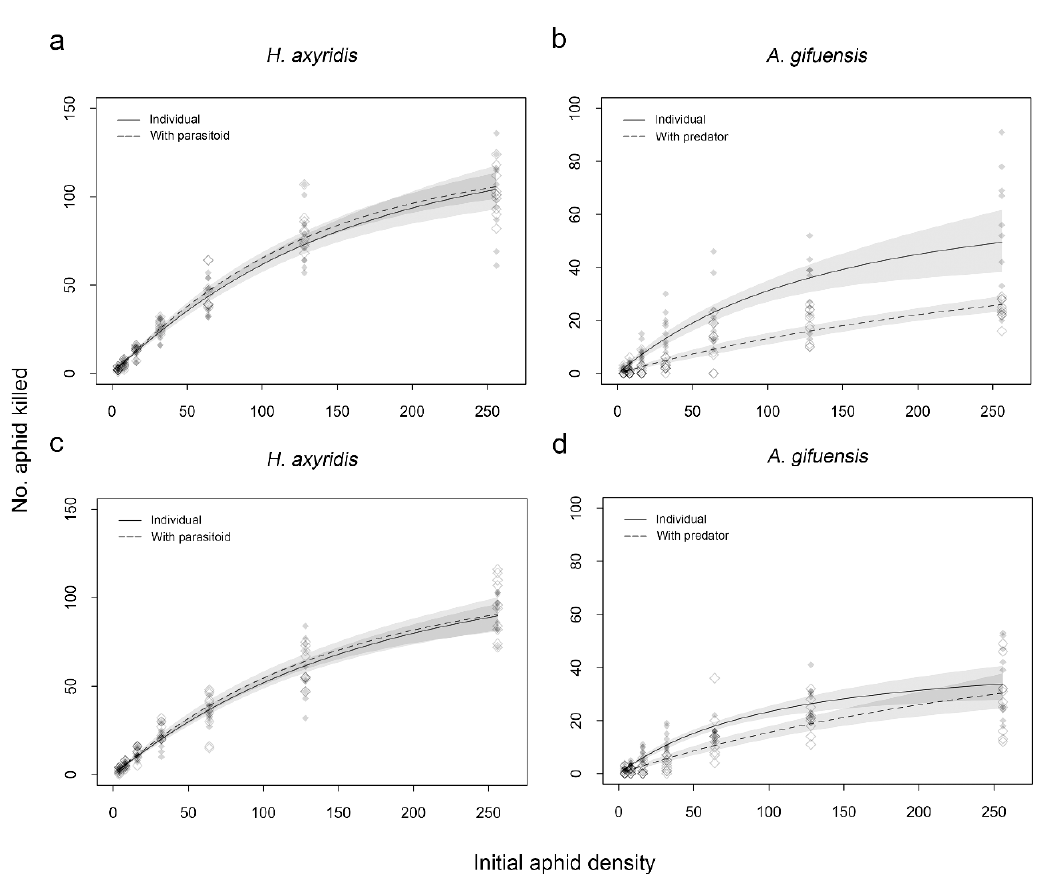
Figure 3. Functional response of single Harmonia axyridis or Aphidius gifuensis and the treatment when H. axyridis or A. gifuensis sharing the experimental unit with heterospecific enemy to densities of Myzus persicae under aggregate treatment ( a , b ) or uniform treatment ( c , d ). Shaded areas are bootstrapped 95% confidence intervals (n = 2000 bootstraps each).